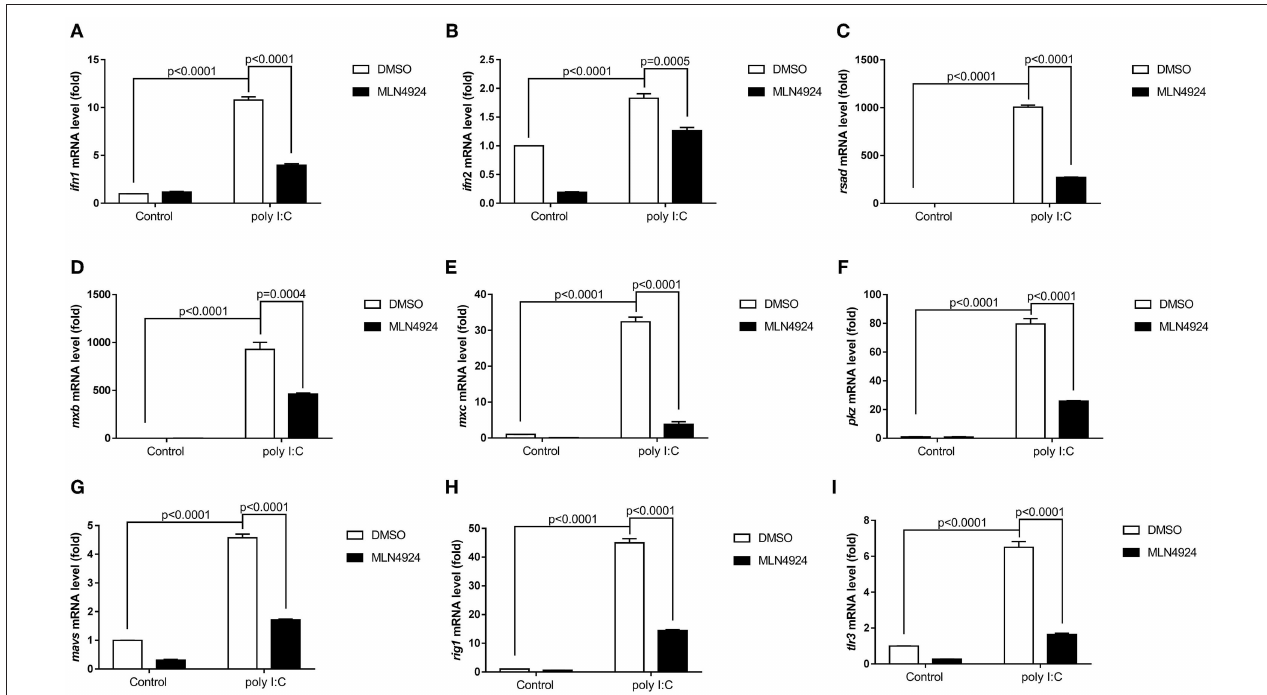
FIGURE 1 | MLN4924 suppresses the expression of IFN and ISGs in ZFL cells after poly (I:C) stimulation. (A–I) Treatment of ZFL cells with 1 µ M MLN4924 after poly(I:C) stimulation downregulated ifn1 (A) , ifn2 (B) , rsad (C) , mxb (D) , mxc (E) , pkz (F) , mavs (G) , rig1 (H) , tlr3 (I) . Additions of the same amount of DMSO were used as controls. Data are shown as mean ± SEM of three independent experiments, each performed in triplicate; the statistical analysis was performed using GraphPad Prism 5 (unpaired t -test).